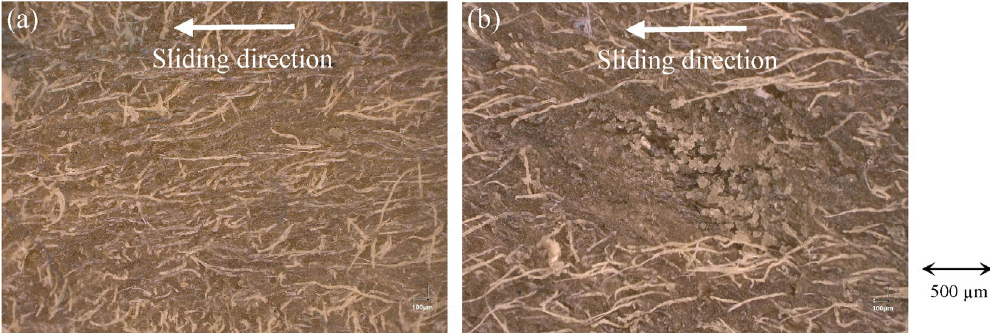
Fig. 10 Wear surfaces after tribometer tests: (a) composite 15 SF when the Amontons’ law is valid (contact pressure of 0.20 MPa) and (b) composite 15 SF when the Amontons’ law is not valid (contact pressure of 0.24 MPa).